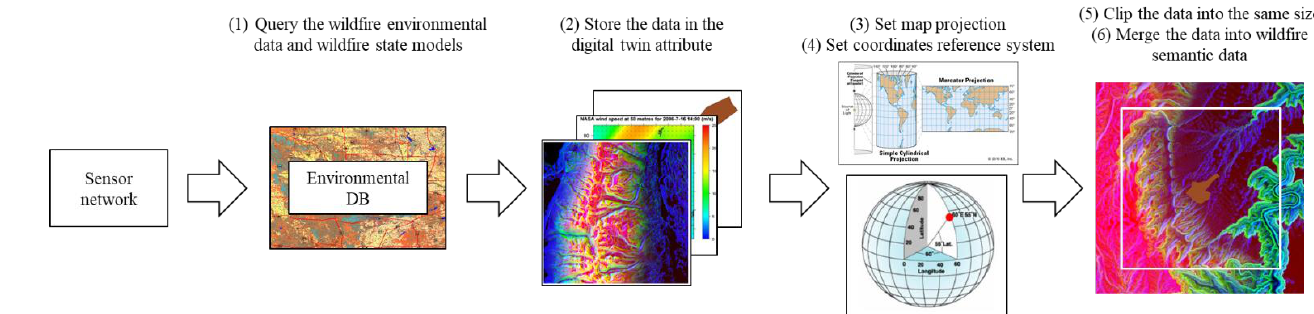
Figure 11. The wildfire digital twin data preprocessing procedure.